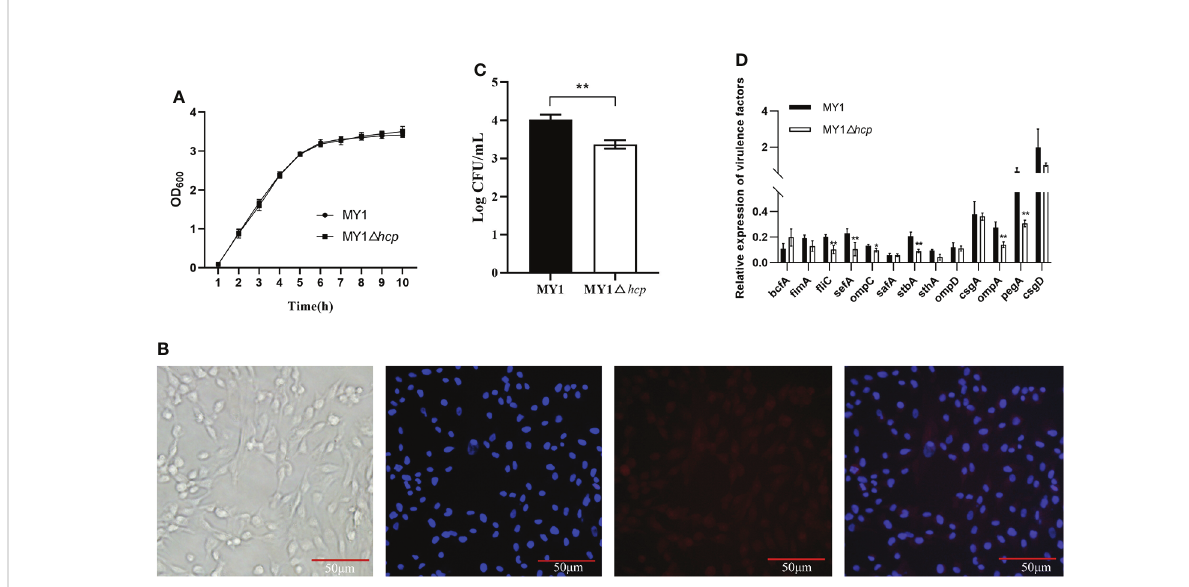
FIGURE 1 Construction and the invasion assay of the mutant MY1 △ hcp . (A) Growth curves of wild-type Salmonella Enteritidis MY1 and the mutant MY1 △ hcp . Bacteria were grown in LB at 37°C for 10 h with agitation, and OD 600nm values of triplicate cultures were measured every 1 h. Data are the means of three independent experiments. The two-way ANOVA was performed for growth curves ( P < 0.05). (B) Isolation and identi fi cation of dGCs. Diagram of a dGC (400×), DAPI staining of cell nucleus, and fl uorescent image of FSHR. (C) Adherence to dGCs by wild- type Salmonella Enteritidis MY1 and the mutant MY1 △ hcp . (D) qRT-PCR analysis of the changes of virulence factors expression between MY1 and MY1 △ hcp strain. Data are expressed as mean ± SD of triplicate experiments. **Indicates statistically signi fi cant difference compared with the wild-type strain ( P <